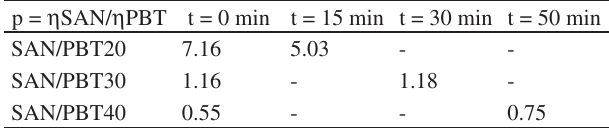
, of the PBT and SAN samples, measured at 0 (Pa.s) η 0